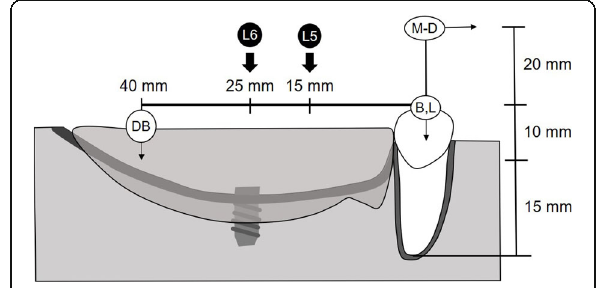
Fig. 4 Schematic illustration of the resin mandibular model for mechanical simulation and denture